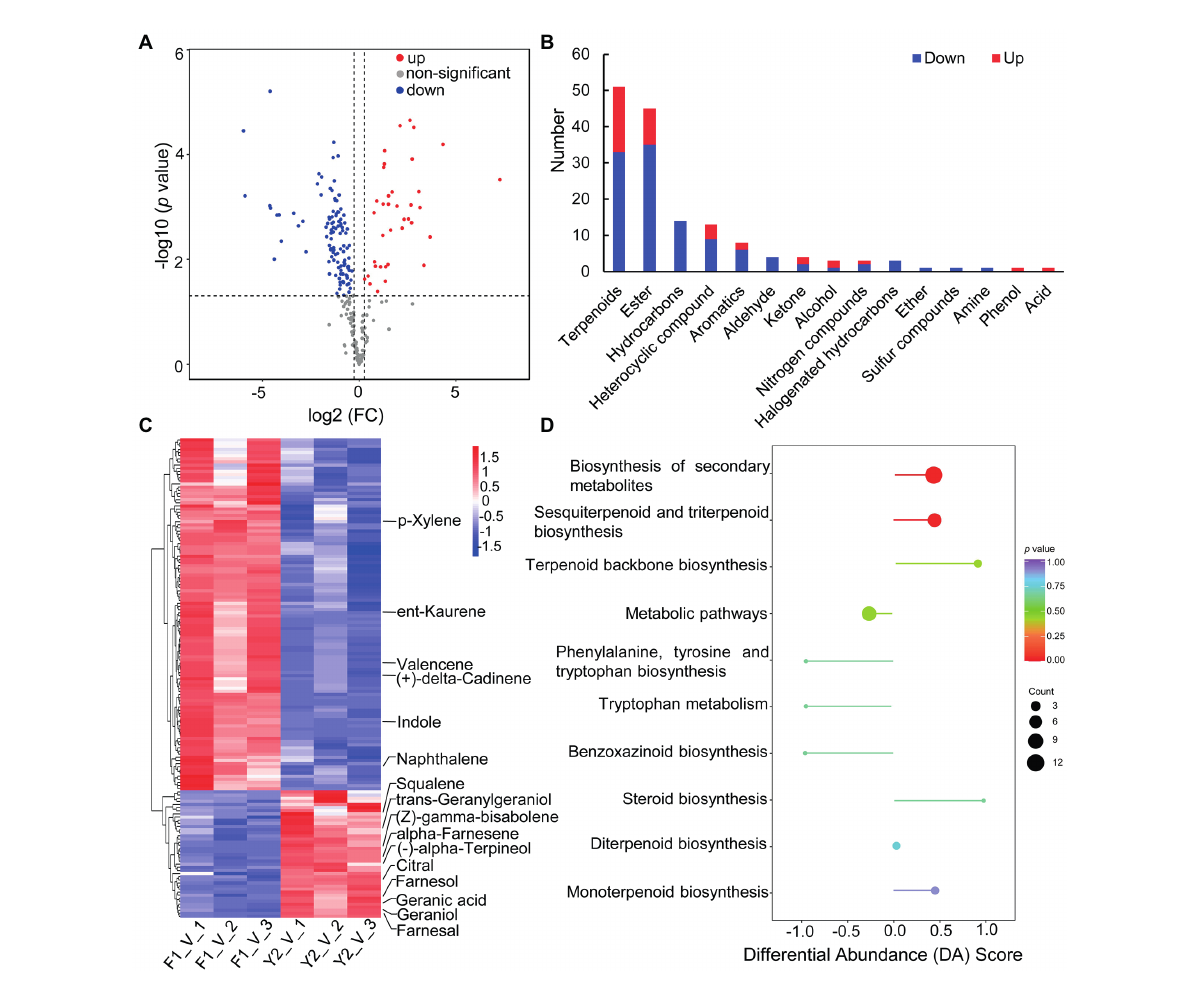
FIGURE 3 Characterization of differentially accumulated volatiles (DAVs) between ‘Yujin2’ and ‘Fengjin1’ LJF samples. (A) Volcano plot of the identified VOCs. The increased and decreased DAVs are shown in red and blue, respectively. (B) Abundance patterns of DAVs in each class. (C) Hierarchical clustering analysis of DAVs. The columns represent different samples, and the rows represent individual DAVs. The colors in the heat map represent the normalized values of DAVs, reflecting the relative contents. DAVs with high or low levels are indicated in red or blue, respectively. Detailed information is provided in Supplementary Table 4. The key DAVs that were functionally annotated through the Kyoto Encyclopedia of Genes and Genomes (KEGG) enrichment analysis are highlighted on the right. (D) KEGG enrichment analysis of the DAVs. The ordinate represents the enriched pathway name. The abscissa represents the differential abundance score (DA score), which reflects the overall change in DAVs in the pathway. The length of the line segment represents the absolute value of the DA score, and the size of the dot at the endpoint of the line segment represents the number of DAVs involved in the pathway. For dots shown on the right panel, the longer the line segment, the more inclined the overall expression of the pathway to be upregulated. In contrast, for dots shown on the left panel, the longer the line segment, the more inclined the overall expression of the pathway to be downregulated. The color of the line segment and the dot reflects the p